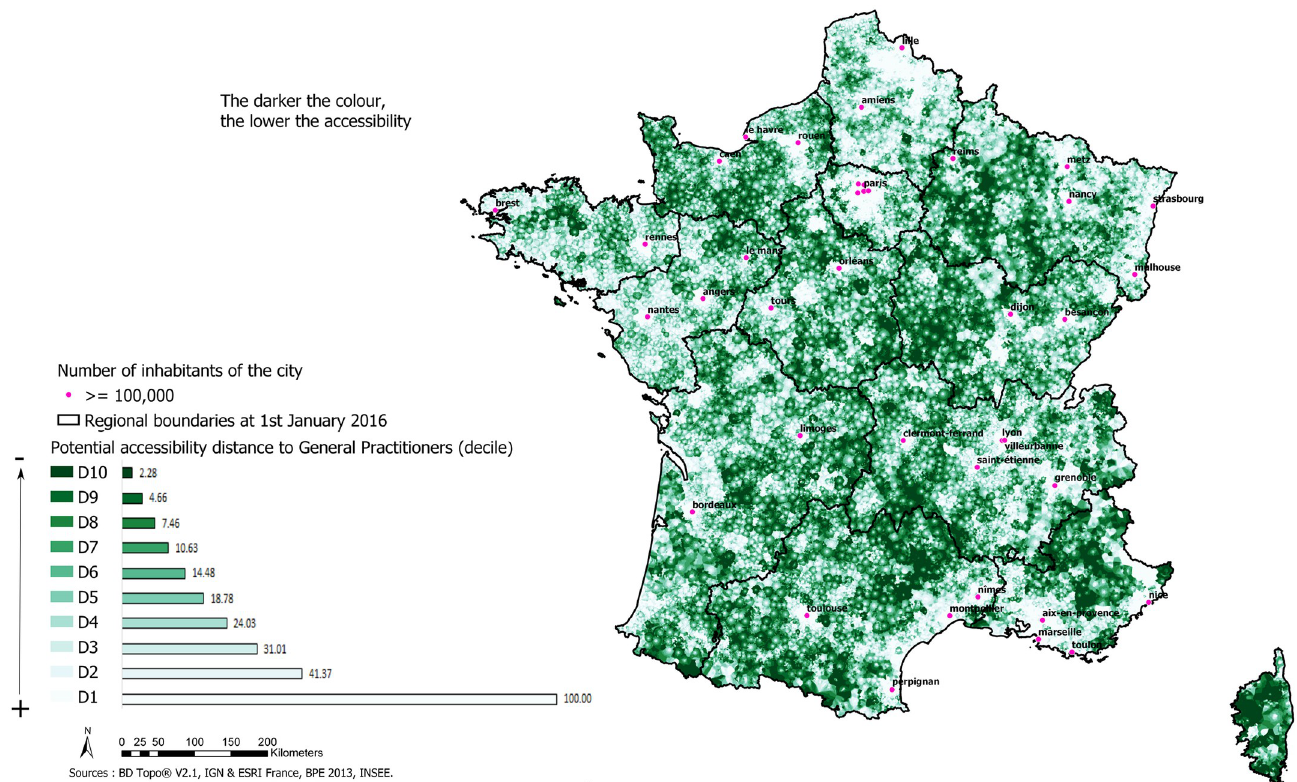
Fig 3. Potential accessibility distance to primary equipment (example for GPs).